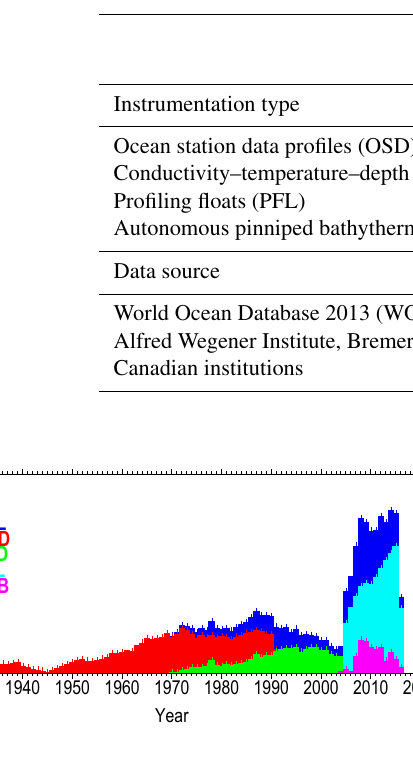
no or insufficient data, meaning that older data (since 1925) were utilized. However, the time frame for the data selection was narrower, especially within the upper 2 km Argo float depth